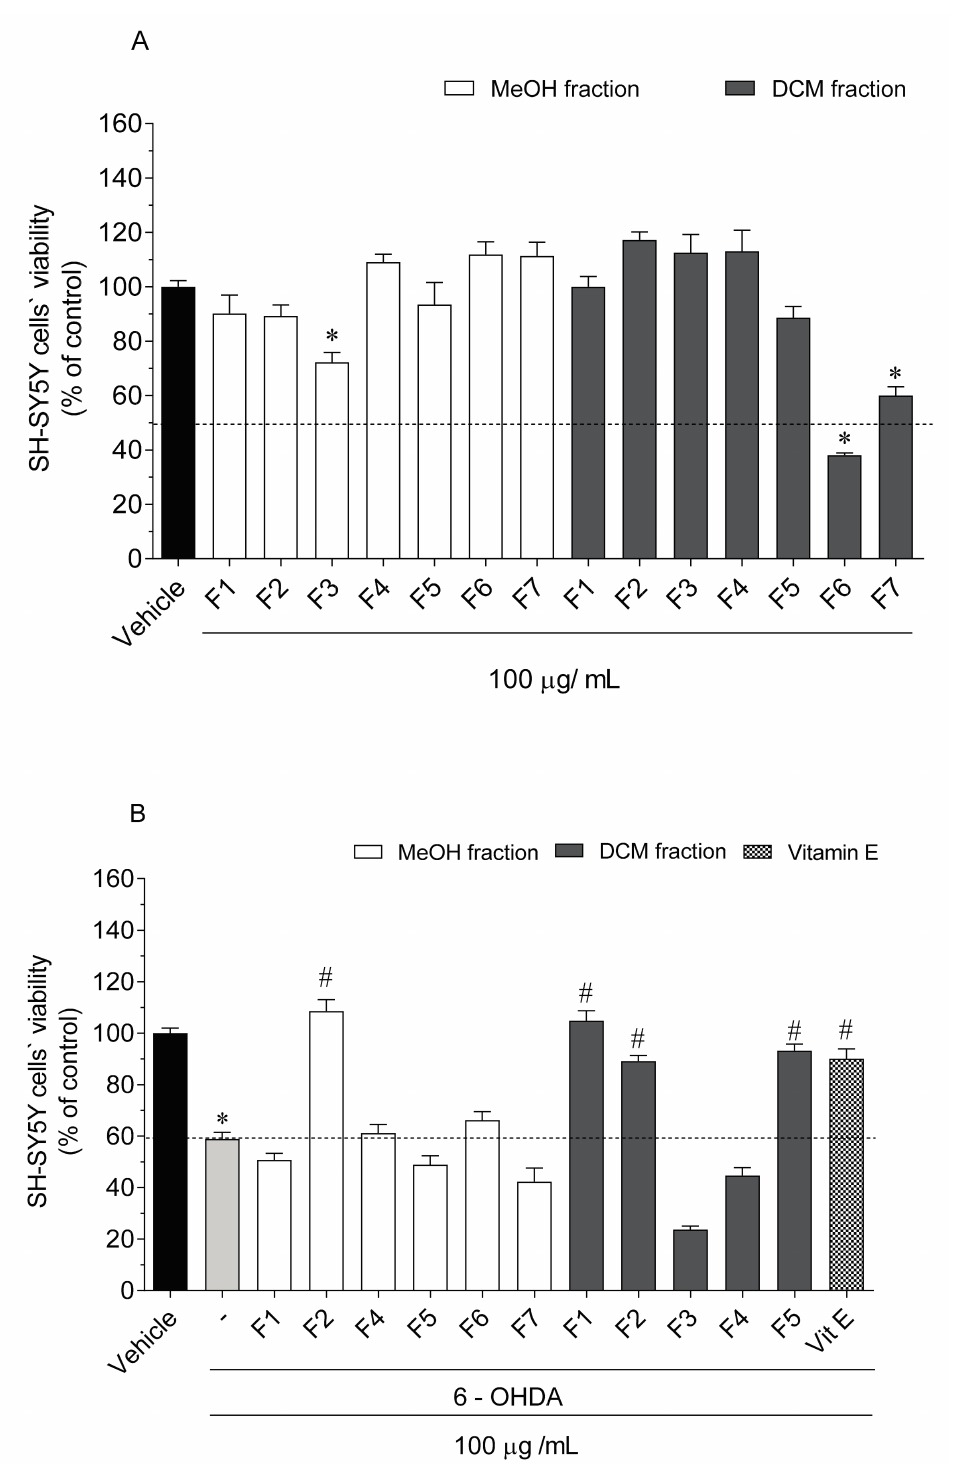
Figure 2. ( A ) Neurotoxicity of Codium tomentosum fractions (100 µ g / mL, 24 h) and ( B ) neuroprotective e ff ects of non-neurotoxic fractions (100 µ g / mL, 24 h) in the presence of 6-OHDA (100 µ M) on SH-SY5Y cells. (-) 6-OHDA; Vit E (Vitamin E). The values in each column represent the mean ± standard error of the mean (SEM) of three or four independent experiments. Symbols represent significant di ff erences (ANOVA, Dunnett’s test, p < 0.05) when compared to: * vehicle and #